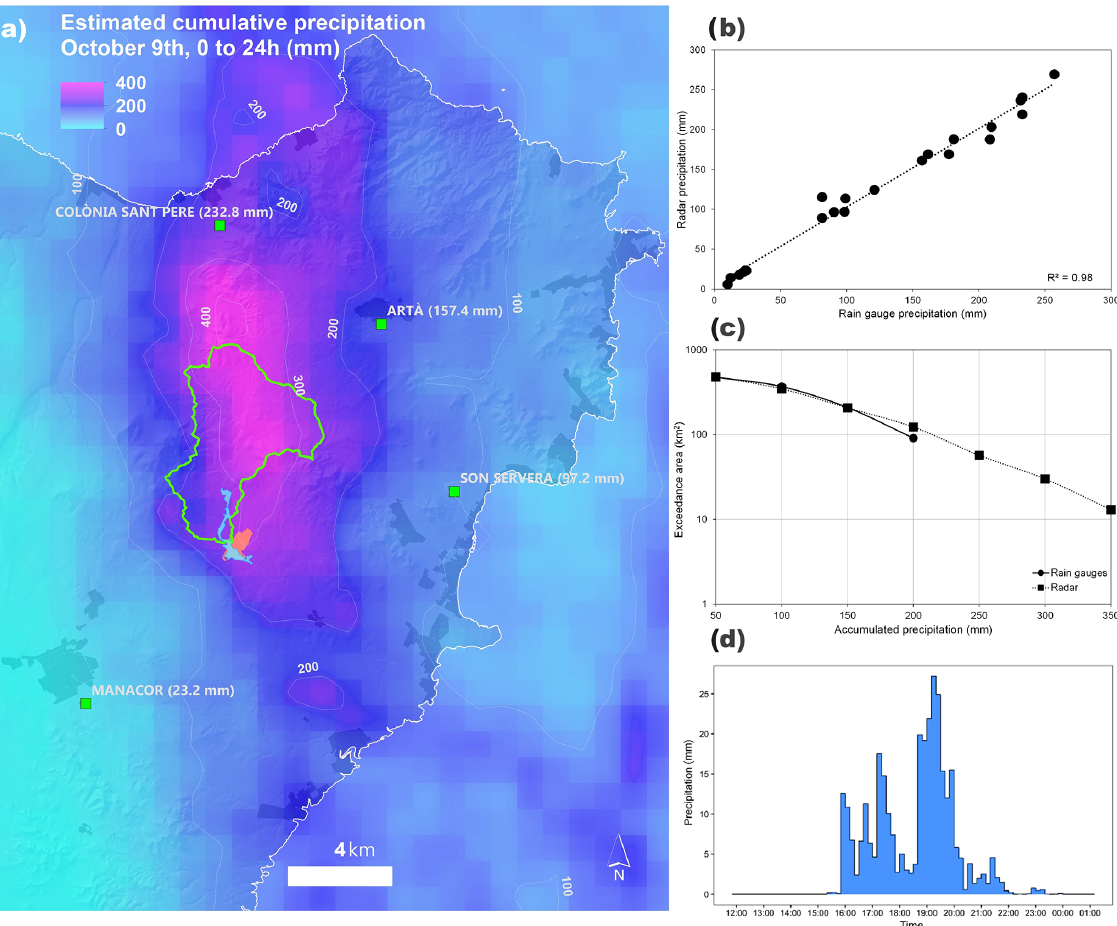
Figure 3. (a) Spatial distribution of the 24h estimated cumulative precipitation for the 9 October 2018 flash flood. Automatic rain gauges used for bias correction are shown as squares. Circles depict the daily pluviometric stations. (b) Scatter plot of the 24h accumulated precipitation derived from radar estimates and pluviometric stations. (c) Comparison of the curves of exceedance areas for different rainfall thresholds derived from the 24h accumulated pluviometric and radar-based rainfall amounts. All pluviometers shown in (a) have been used for the computation (21 stations). (d) Radar-driven precipitation for the 9 October 2018 episode at the Ses Planes